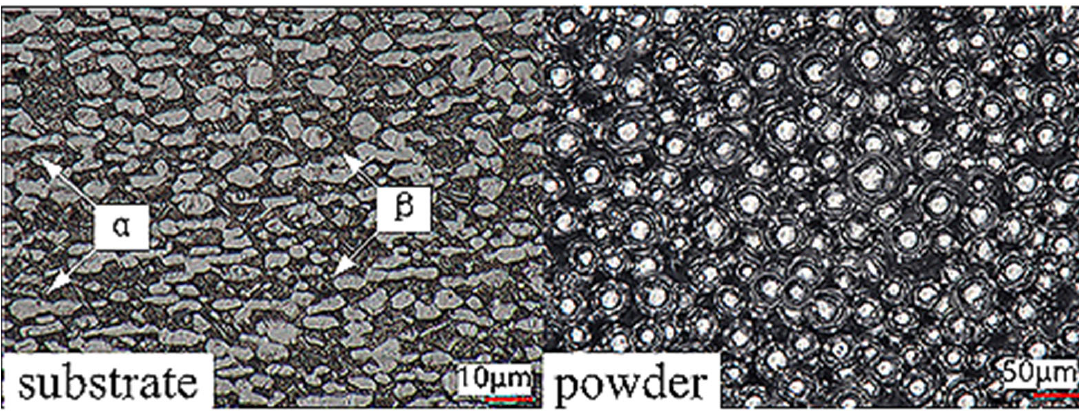
Figure 1. Substrate and powder morphology.